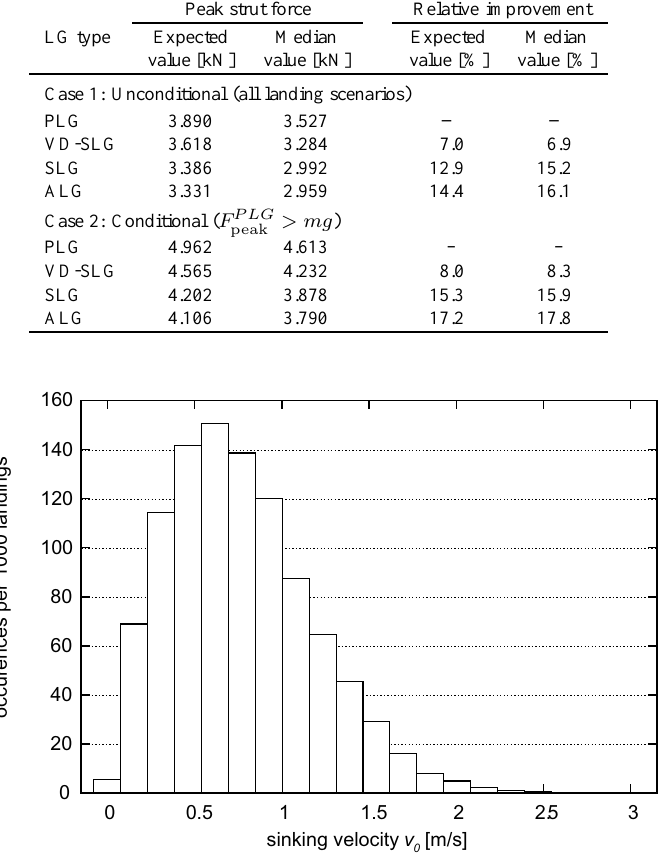
Fig. 15. Assumed occurrences of sinking velocities per 1000